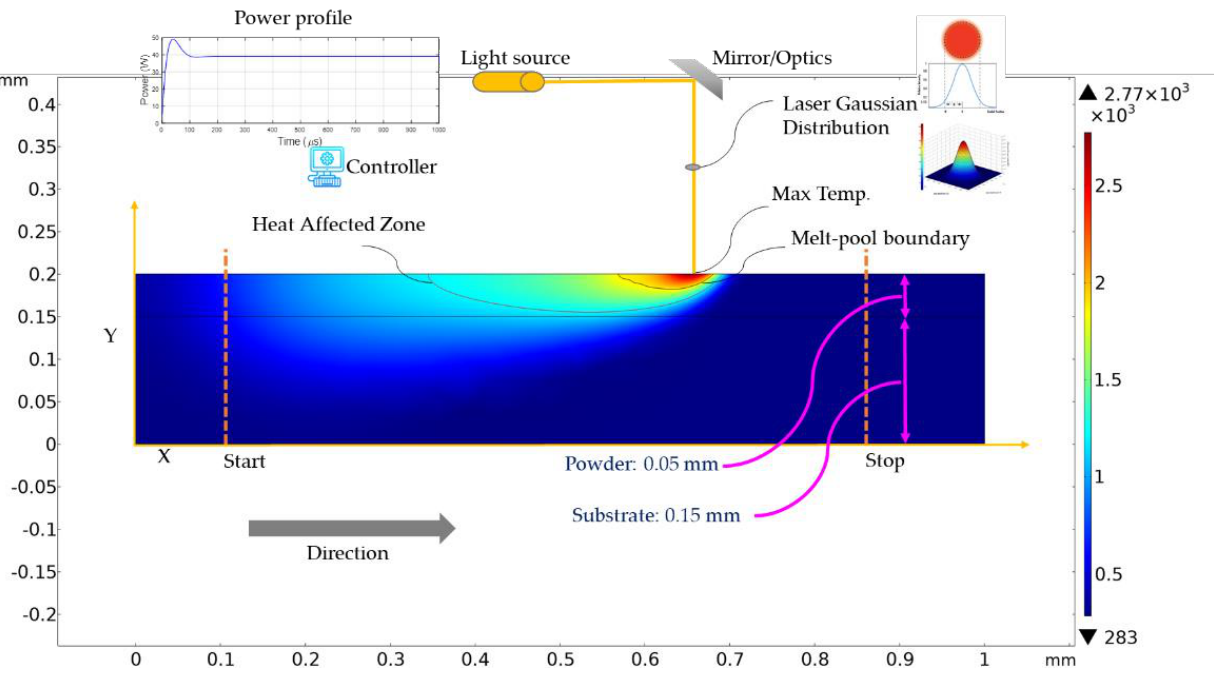
Metals 2021 , 11 , x FOR PEER REVIEW 7 of 20